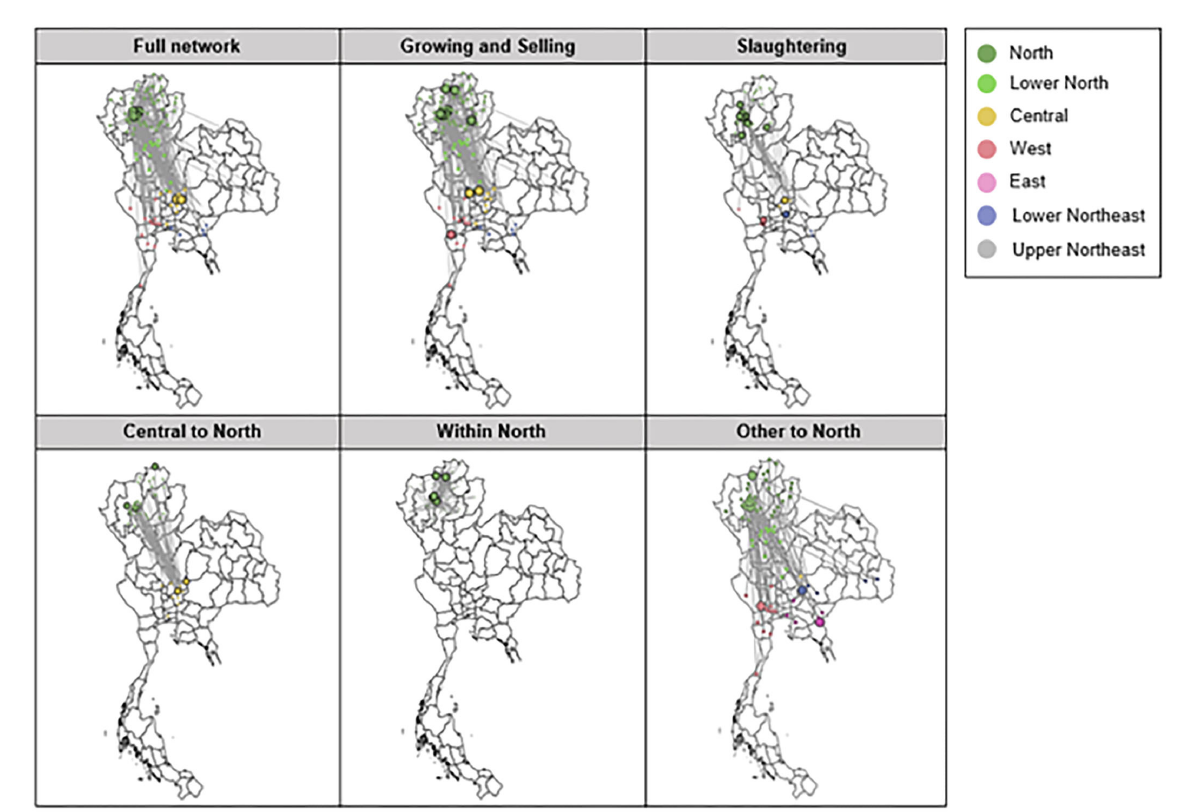
FIGURE4 Full network, networks of movements with growing and selling as the primary purposes of movements, networks of movements from central to northern, within northern, and other to northern regions of Thailand, as overlaid on the geographical map of Thailand. Colored dots represent districts in the movement dataset. Big colored circles represent the influential districts of the dairy cattle movement for each network identified through social network analysis. Directed movement edges are simplified to a single edge between each pair of districts for visualization